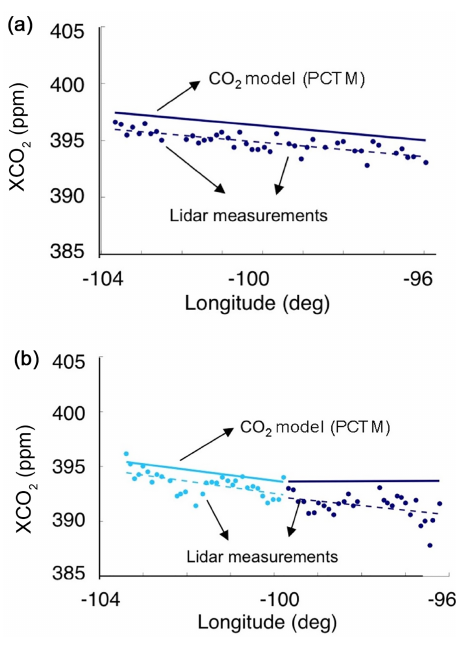
Figure 18. Retrieved XCO 2 from lidar measurements vs. longi- tude for the transit flights to (from) Colorado to (from) Iowa on 2014 SF3. (a) Outbound leg (west-to-east flight direction, SF3G1, measured from 11.2km altitude) and (b) return flight leg (east-to- west flight direction, SF3G2, with dark blue points measured from 5.6km altitude and light blue points from 6.3km altitude). The mea- surements shown are for retrievals using 50s data averages, and the flight altitudes are indicated. The solid lines show the XCO 2 values computed from the PCTM atmospheric model for that location and these